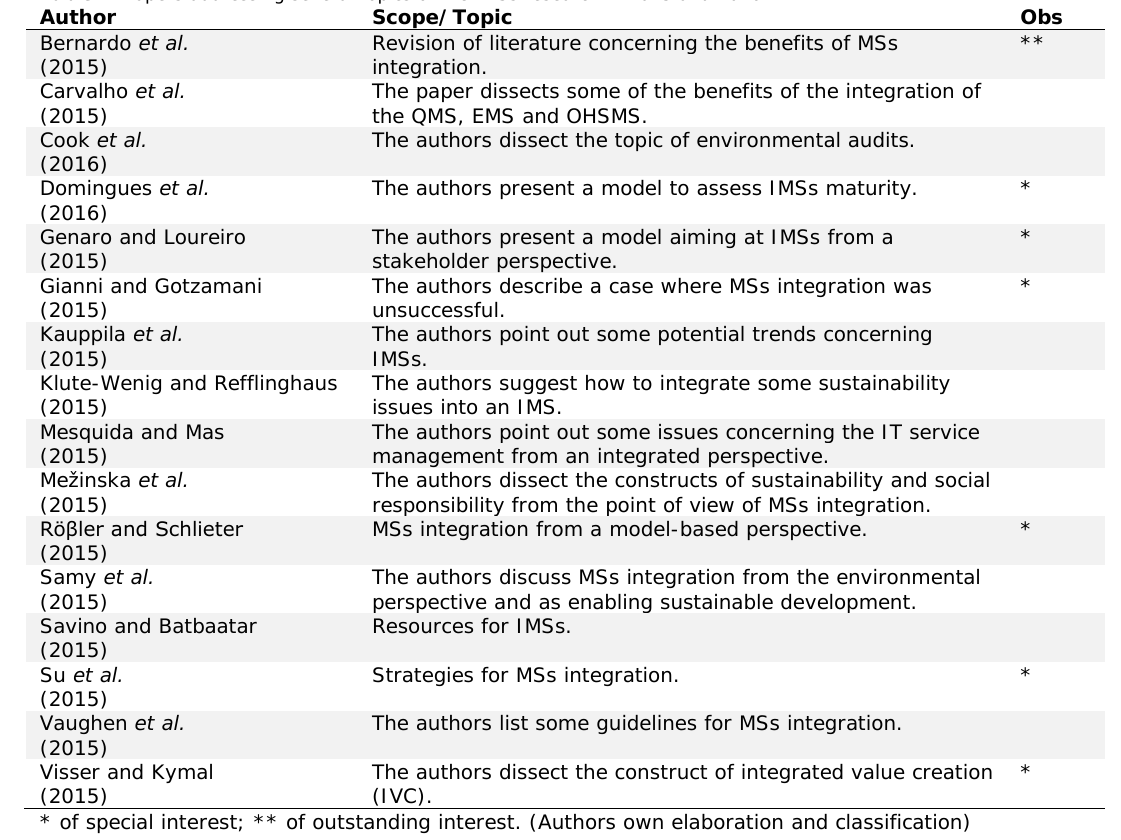
Table 1. Papers addressing several topics of the IMSs research in 2015 and 2016. Author